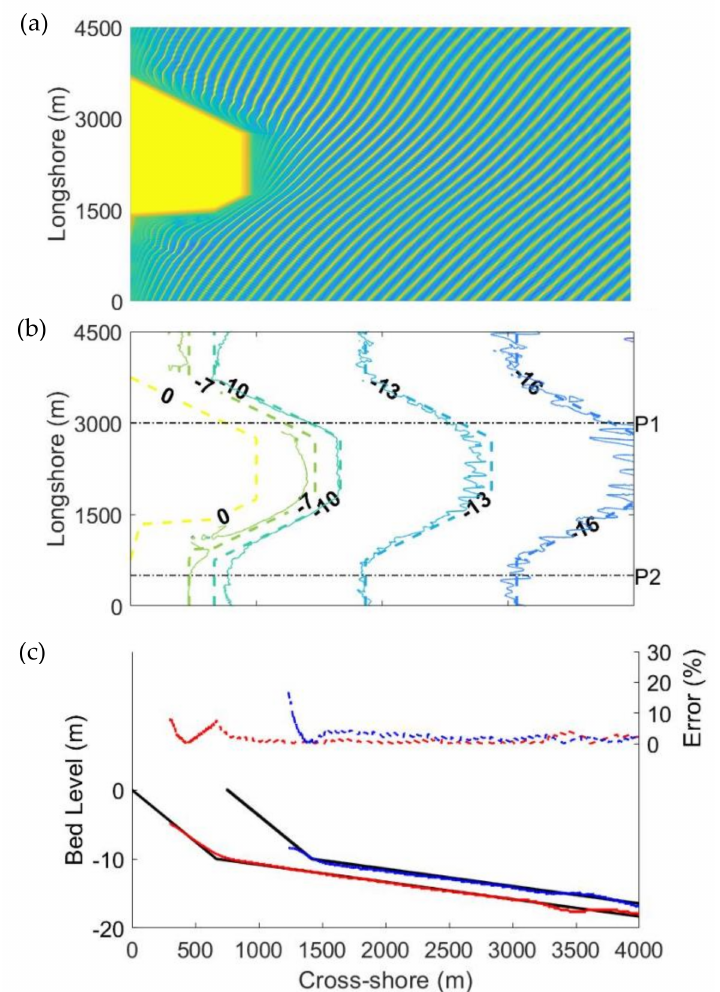
Figure 6. Regular waves propagating to a headland at oblique incidence: ( a ) generated image representing the two-dimensional wave propagation at the surface; ( b ) isobaths of the calculated bathymetry (continuous lines) over the real bathymetry (dashed lines); ( c ) cross-shore profiles P1 and P2 (real—black lines; estimation using wavelets—red and blue lines) and respective relative errors. FUNWAVE numerical simulations performed with H = 2 m, T = 10 s, θ = 30 ◦ , and dx = 1 m. Total simulation time was 2500